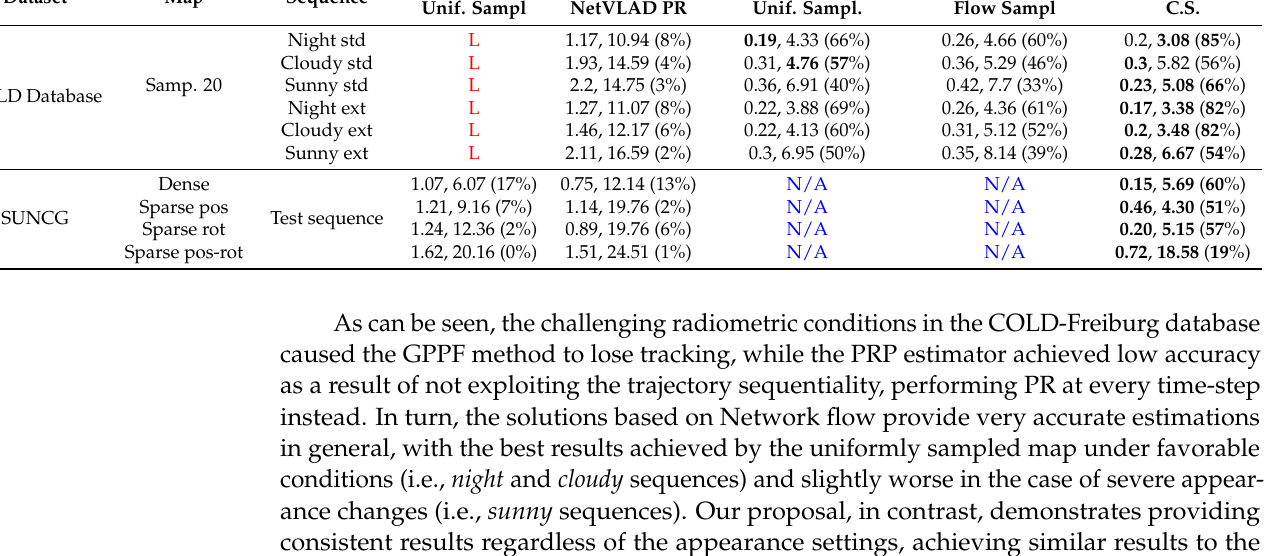
Table 2. Comparative median position and rotation errors, and % of correctly localized frames ( m , ◦ , ( % ) ) of different state- of-the-art appearance-based localization methods. A frame is correctly localized when the distance between the estimate and its true pose is below (0.5m, 10°) (L: sequences where the tracking got lost. N/A: not applicable). PRP—Pairwise Relative Pose estimator; PR—Place Recognition. In bold, best result for each sequence.